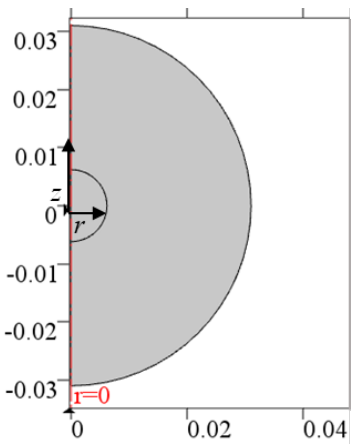
Figure 2. The 2D axisymmetric computational domain.